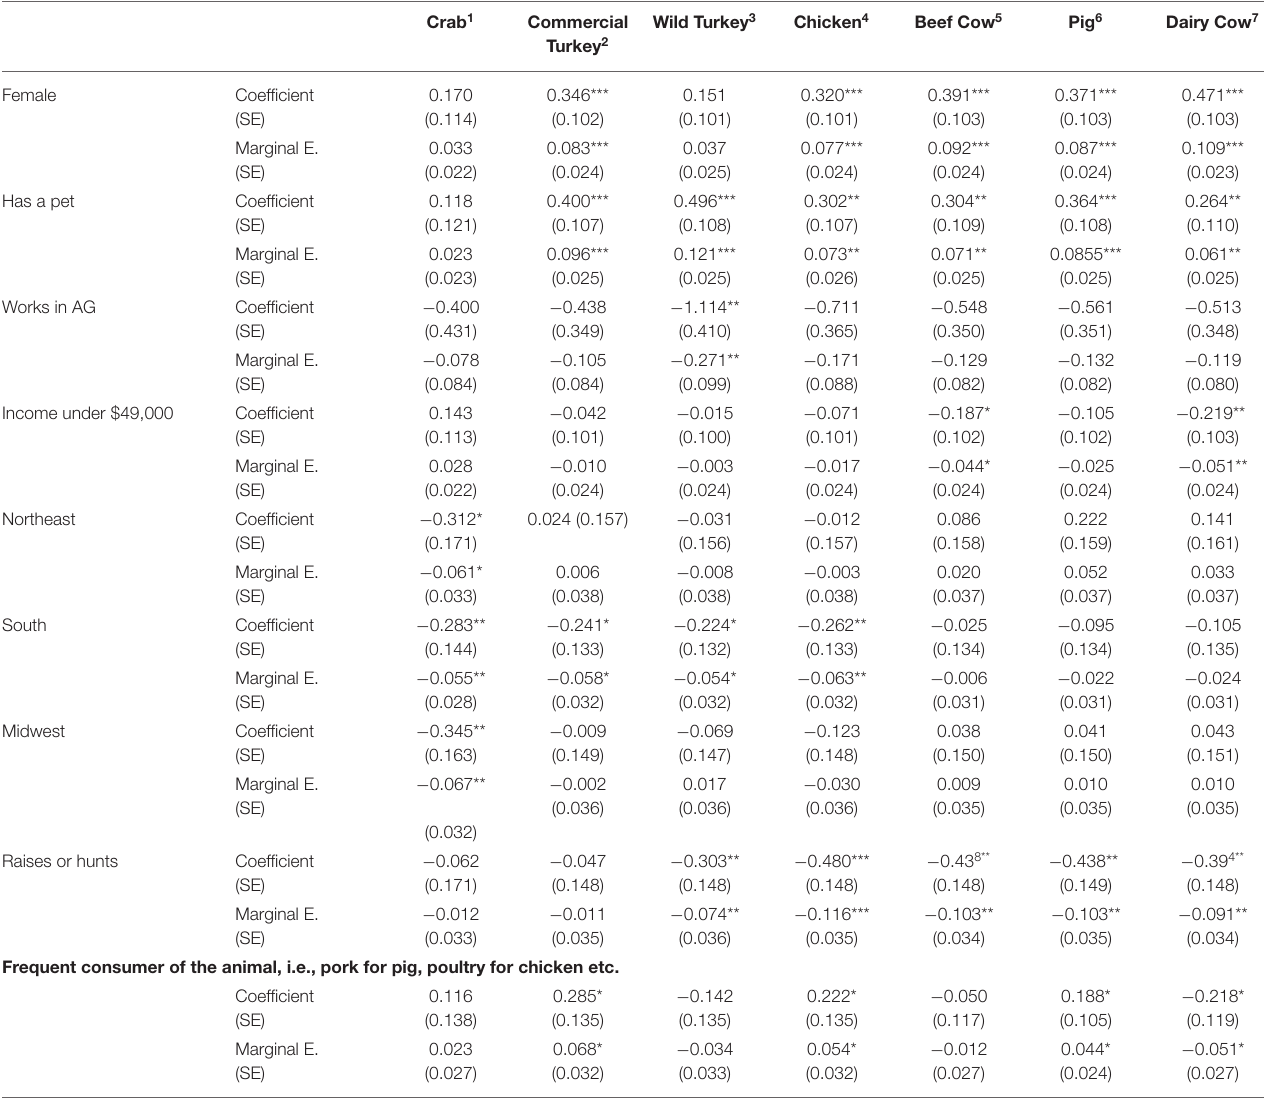
TABLE 8 | Logit models of respondents’ concern for 7